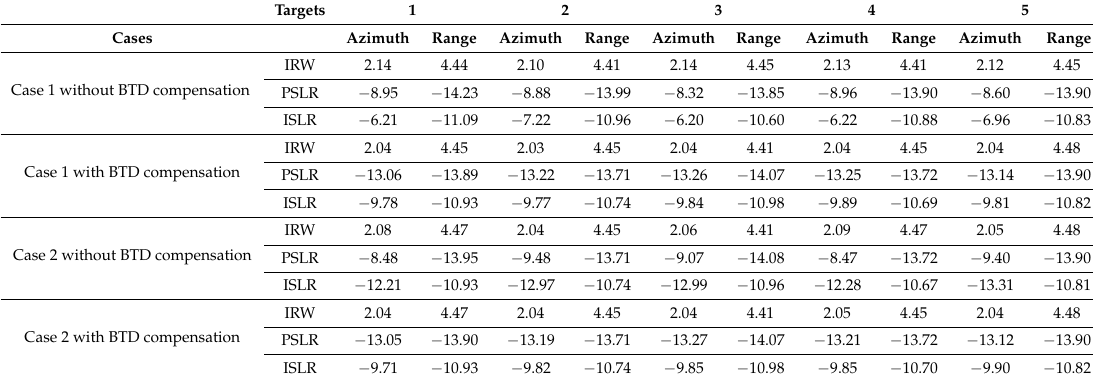
Table 5. The imaging quality of point